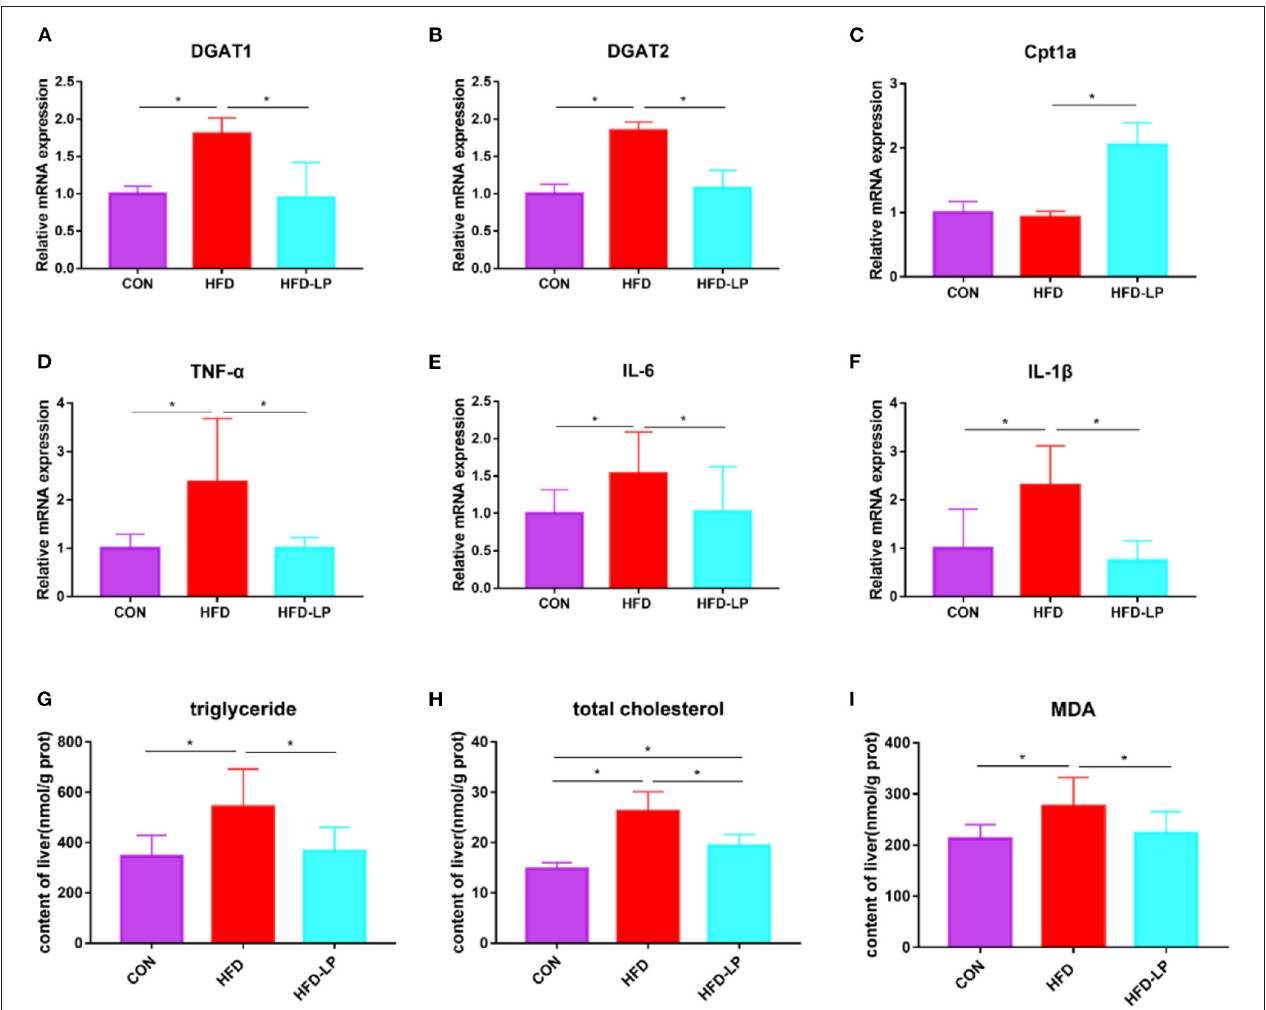
FIGURE 4 | Effects of Lactobacillus plantarum on inflammatory factors and lipid metabolism-related genes in obese mice (A) relative mRNA expression of DGAT1 in colon tissue; (B) relative mRNA expression of DGAT2 in colon tissue; (C) relative mRNA expression of Cpt1a in colon tissue; (D) relative mRNA expression of TNF- α in colon tissue; (E) relative mRNA expression of IL-6 in colon tissue; (F) relative mRNA expression of IL-1 β in colon tissue; (G) the content of triglyceride in liver tissue; (H) the content of total cholesterol in liver tissue; (I) the content of MDA in liver tissue. Data are mean ± SD ( n = 8) and analyzed by one-way ANOVA. * p <